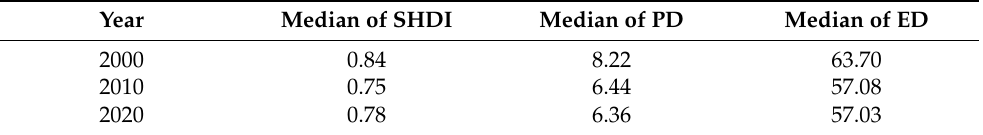
Figure 5. Boxplots of the results of the three landscape metrics of the 73 village buffer zones in 2000, 2010, and 2020. ( a ) Results of Shannon’s diversity index (SHDI); ( b ) results of patch density (PD); ( c ) results of edge density (ED). Table 4. Summary of the median values of SHDI, PD, and ED at the landscape